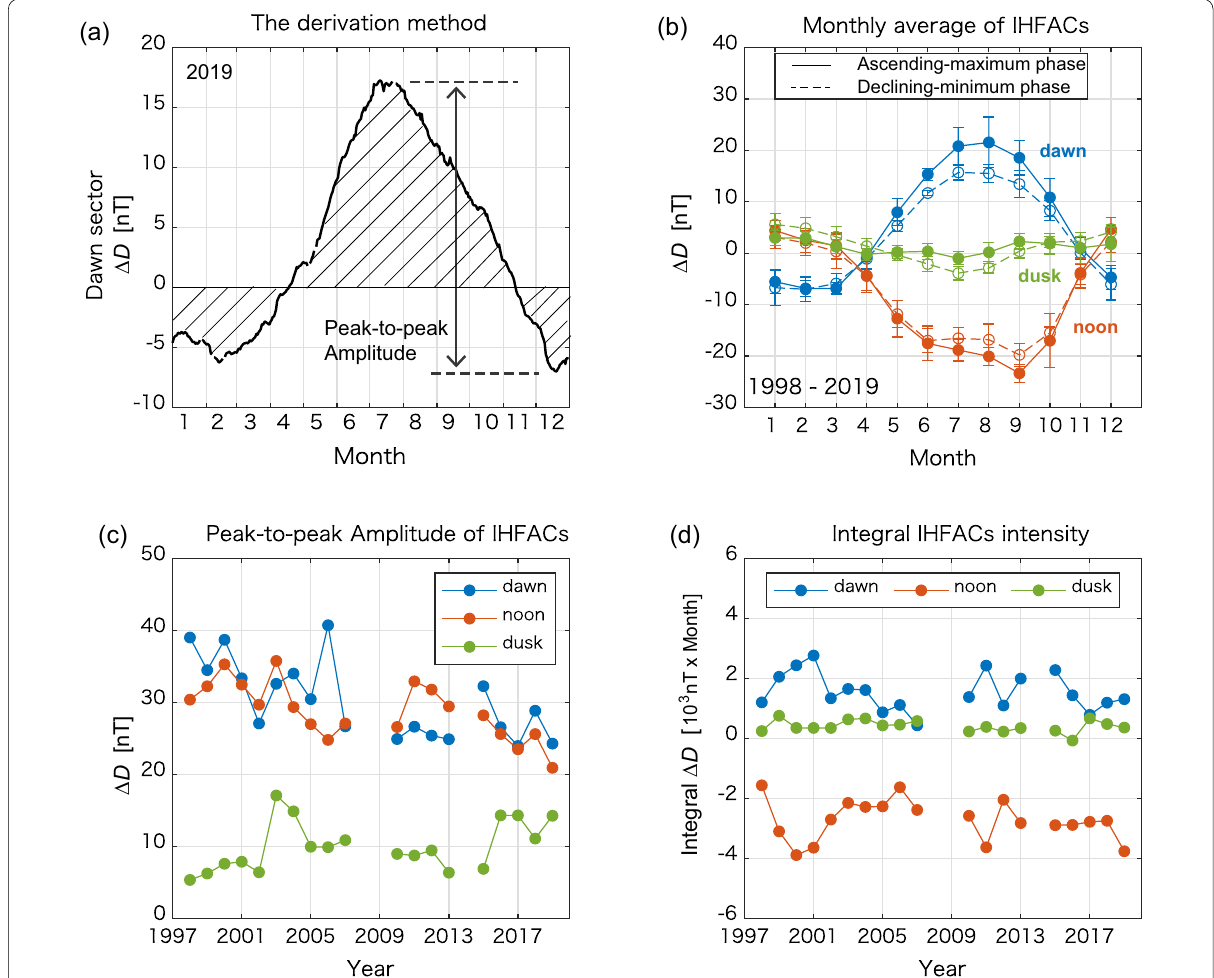
Fig. 3 Solar cycle dependence of ∆ D variations. a Illustration of the derivation method of peak-to-peak amplitude and integral intensity of ∆ D variations; b monthly average of ∆ D variations plotted by the separated groups in terms of solar cycle activity: the ascending-maximum phase (1998–2003, 2011–2015) as shown with solid lines and declining-minimum phase (2004–2010, 2016–2019) as indicated by dashed lines, the error bar shows standard deviations for each data point. c Peak-to-peak amplitude of yearly ∆ D variations; d yearly integral intensity of ∆ D variations, which is provided by the summation of hatched areas in panel ( a ). Through ( b – d) , the blue, red and green colors represent the dawn, noon and dusk sectors, respectively. The data points for 2008, 2009, and 2014 were removed due to the lack of data per